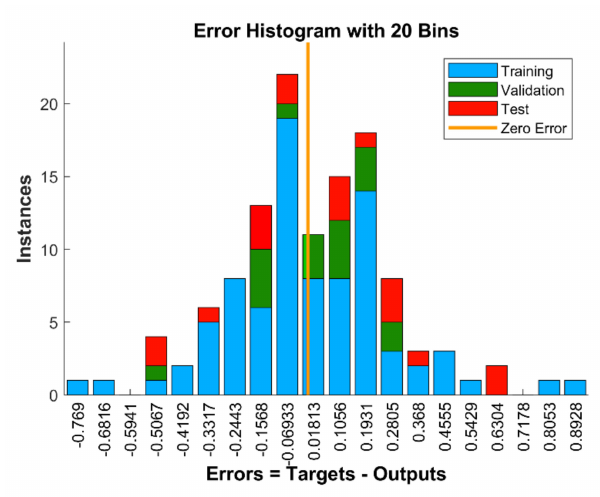
Figure 13. Error histogram of the